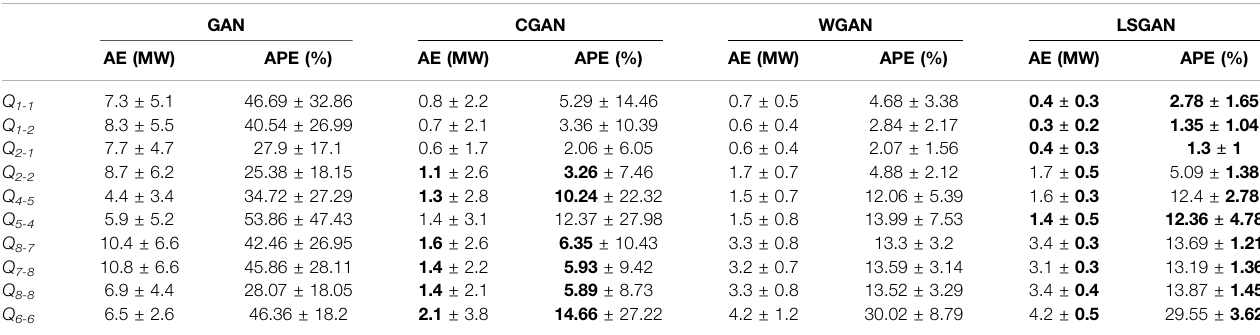
TABLE 2 | The AE and APE statistics of the generated reactive data. GAN CGAN WGAN LSGAN